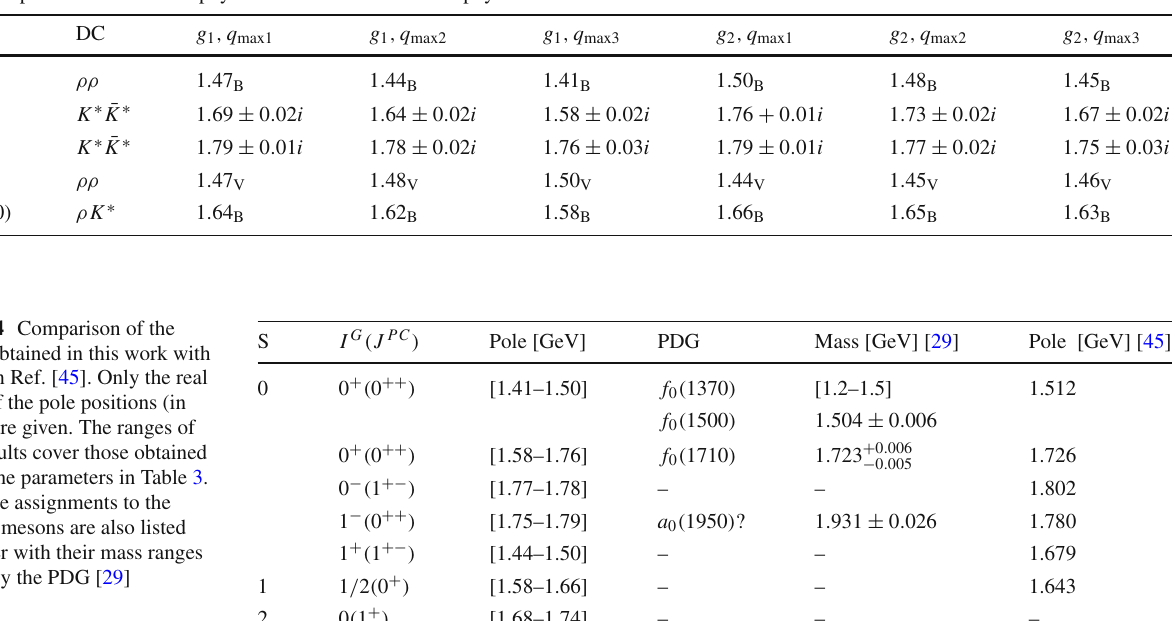
sheets with a significant impact on physical observables are listed. The dominant channels (DCs) are listed in the second column. The notation follows that of Table 2